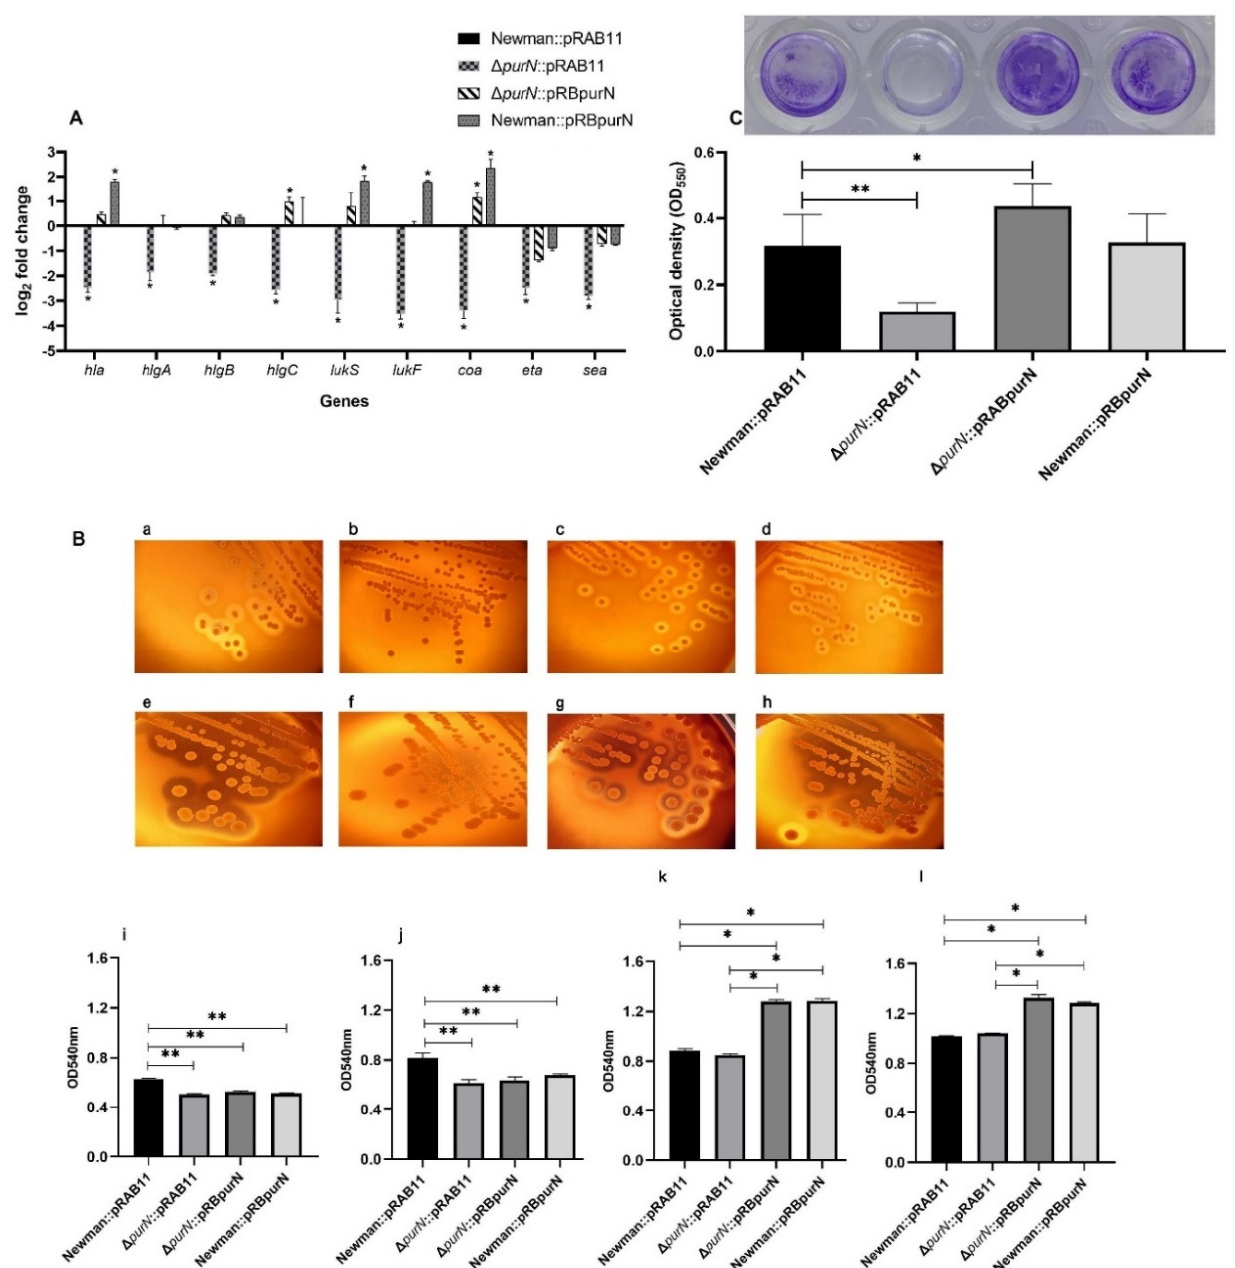
Figure 3. Comparison of the virulence of Newman::pRAB11, ∆ purN ::pRAB11, ∆ purN ::pRABpurN, and Newman::pRBpurN in S. aureus . ( A ) The virulence gene expression levels detected by RT-qPCR. ( B ) Variation of hemolysis in different strains. Hemolysis status of Newman::pRAB11 ( a , e ), ∆ purN ::pRAB11 ( b , f ), ∆ purN ::pRABpurN ( c , g ), and Newman::pRBpurN ( d , h ) cultured for 24 h ( a – d ) and 48 h ( e – h ) on blood TSA plates. The hemolysis assay of the four strains was measured in different time points cultures. ( i )10 h, ( j ) 14 h, ( k ) 24 h, and ( l ) 48 h. ( C ) The biofilm formation abilities of the four S. aureus strains in 96-well plates. Comparison of OD 550 and biofilm images in 96-well plate of different strains. * p < 0.05, ** p < 0.01.